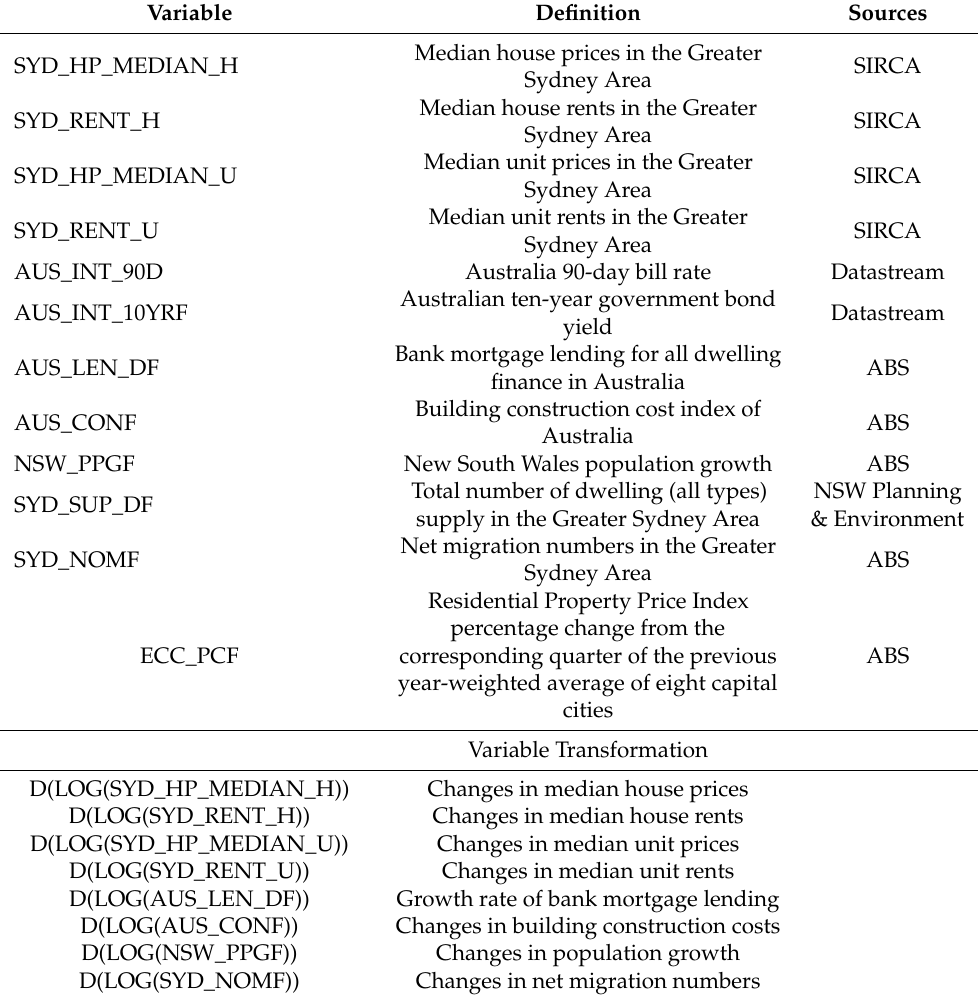
Table 1. Definition of